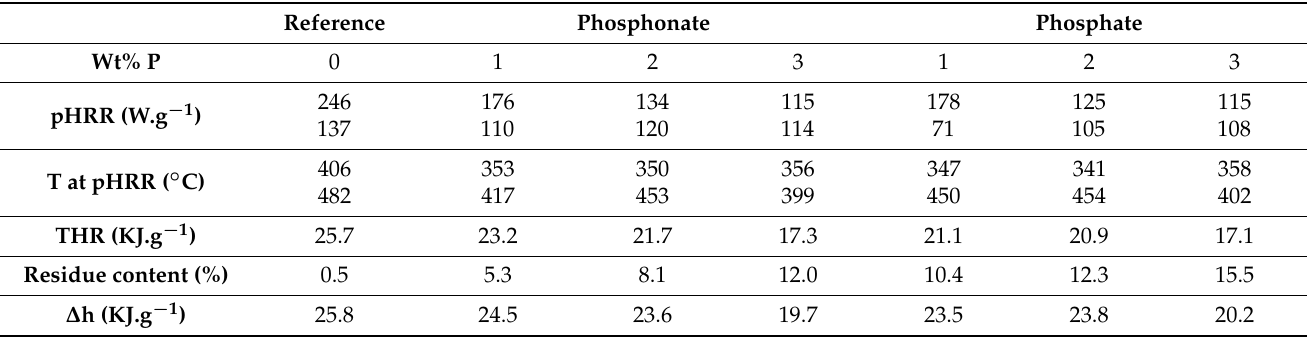
Table 4. Results of PCFC analyses of PO x CR diluent alkyd resins.